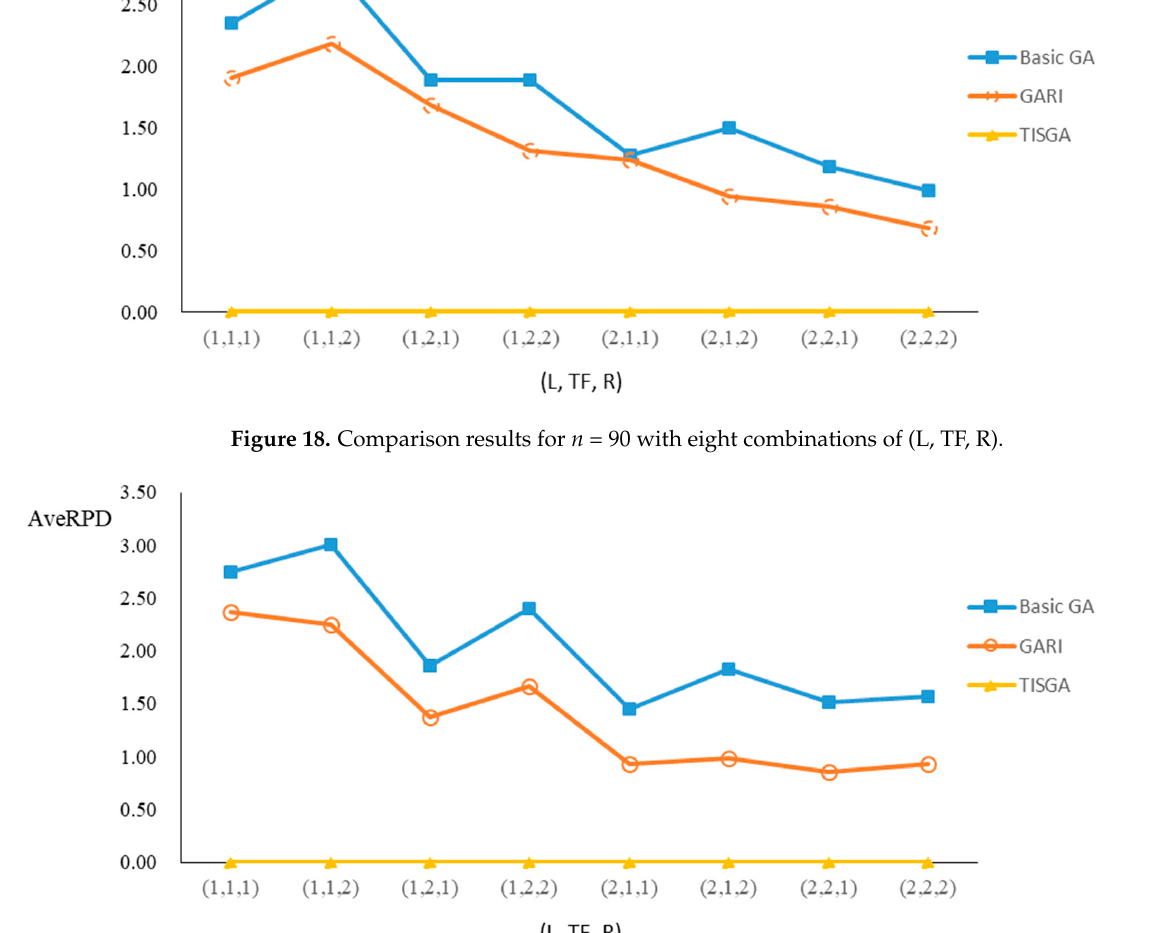
Figure 19. Comparison results for n = 100 with eight combinations of (L, TF, R).